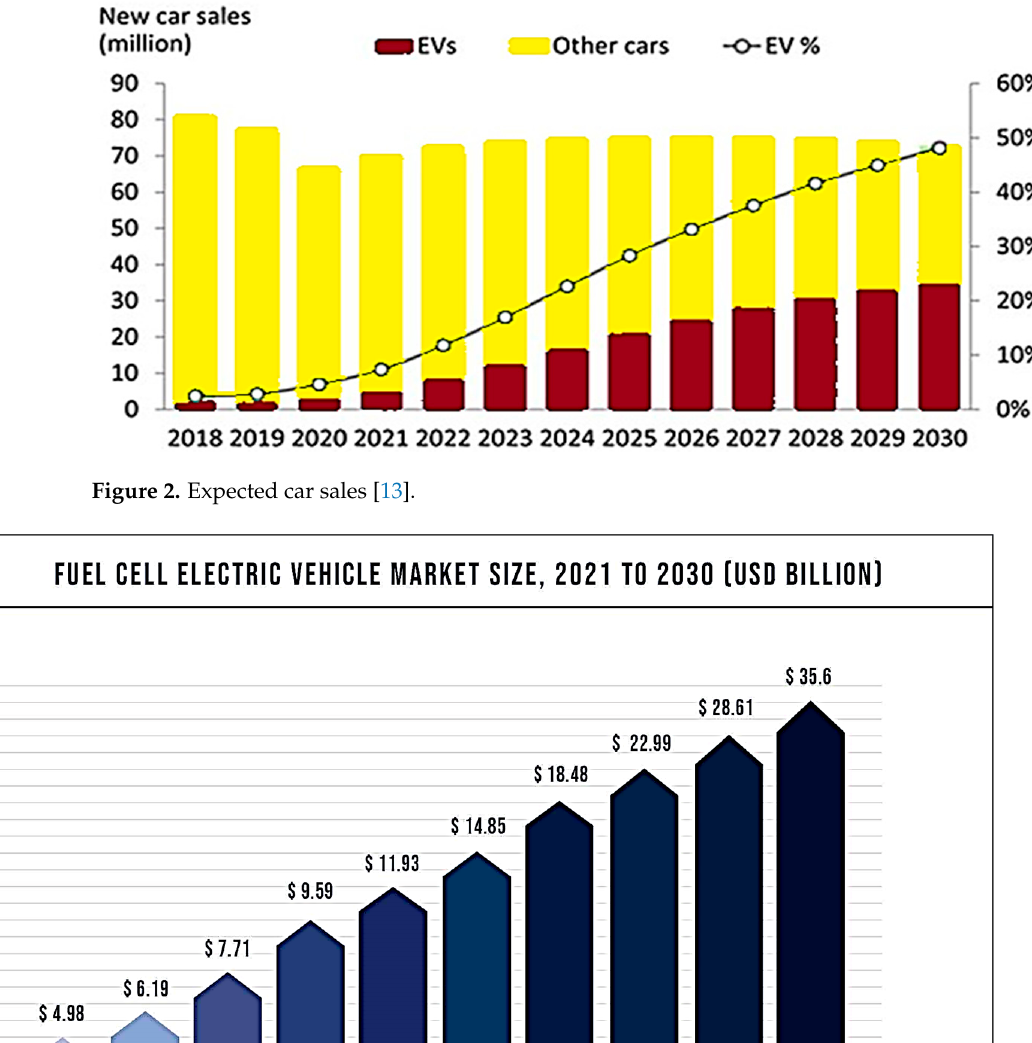
Figure 2. Expected car sales [13].